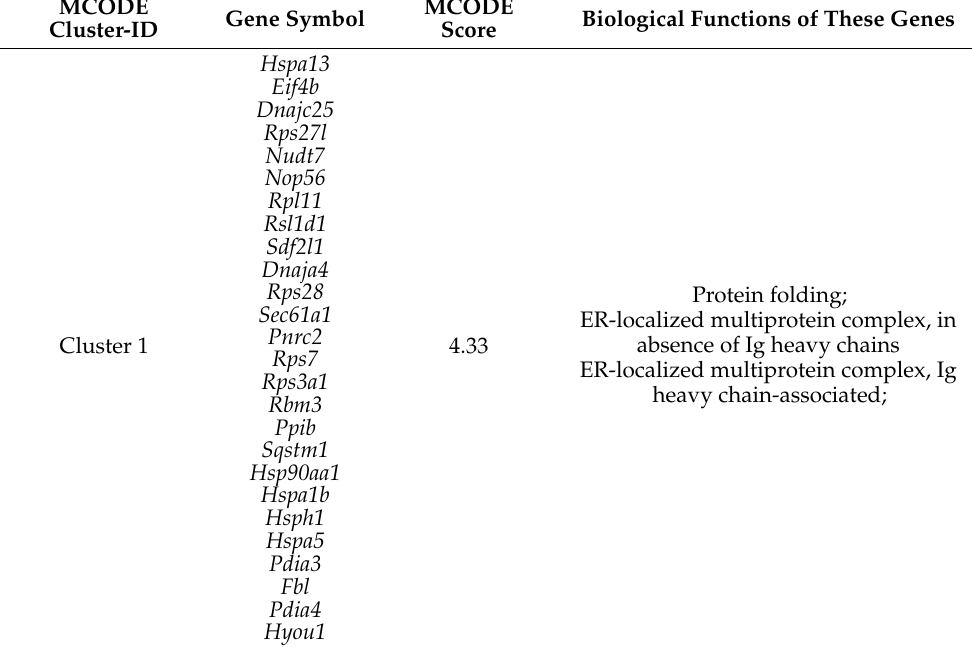
Table 3. The list of clustered hepatic DEPs identified by